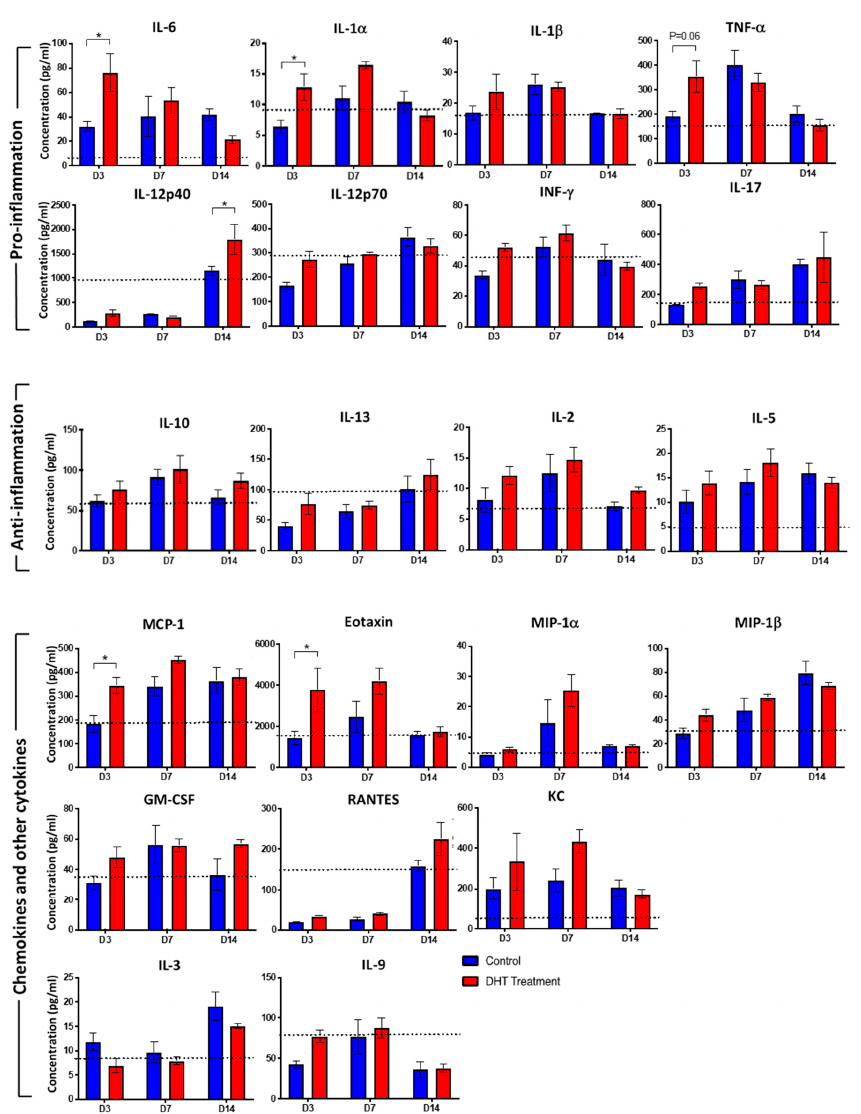
Figure 3. Cytokines response to major burn injury.Mouse cytokine 23-plex assay showing inflammatory cytokines regulating the systemic inflammatory response to control (Blue) and DHT treatment (Red) post major burn injury. IL-1 α , IL-6, MCP-1, Eotaxin raised in DHT-treated mice at day 3 and IL-12p40 raised in DHT-treated mice at day14. (IL-4 and G-CSF not shown as the concentration were below detectable levels). Data presented as mean with a standard error of the mean (SEM). Black dotted lines indicate cytokine levels in non-injured control mice. N = 3 per time point for control and DHT treatment. * p ≤ 0.05 DHT treatment vs. control.